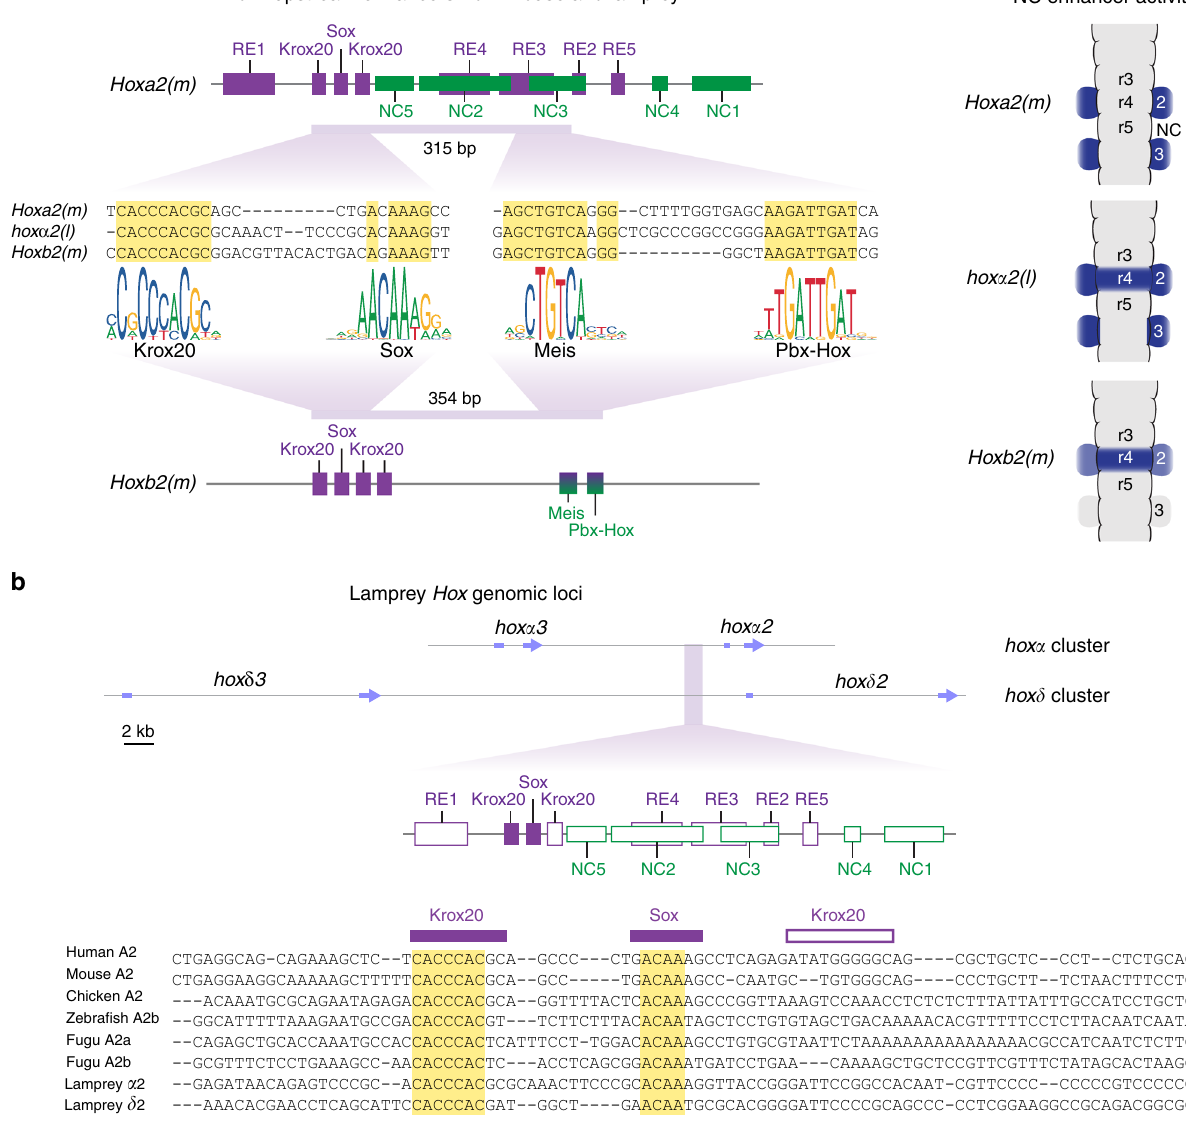
Fig. 5 Hoxa2 and Hoxb2 neural crest (NC) enhancers are ancient paralogues and the lamprey hox α 2 enhancer appears to re fl ect the ancestral state. a Sequence alignment of mouse (m) Hoxa2 and Hoxb2 NC enhancers with that of lamprey (l) hox α 2 , revealing short conserved sequence blocks (yellow). Corresponding consensus binding motifs for Krox20, Sox, Meis, and Pbx-Hox factors are shown below the alignment. These conserved sequences map to characterized cis -elements required for hindbrain (purple) or NC (green) activity in the mouse Hoxa2 (above) and Hoxb2 (below) enhancers. The 315 and 354 bp refer to the precise distances between the 5 ′ end of the Krox20 site and the 3 ′ end of the Pbx-Hox site of the mouse Hoxa2 and Hoxb2 enhancers, respectively. The activity of each NC enhancer in the hindbrain and NC is shown in schematic dorsal views. This activity differs between each enhancer, with hox α 2(l) showing the combined output of Hoxa2(m) and Hoxb2(m) . b Multiple sequence alignment of gnathostome Hoxa2 NC enhancers with a homologous region upstream of lamprey hox δ 2 . The lamprey hox α 2 - hox α 3 and hox δ 2-hox δ 3 genomic loci are depicted, with hox gene exons annotated (blue arrows). The multiple sequence alignment reveals conservation of a Krox20 and a Sox site upstream of hox δ 2 (yellow shading in alignment), but other cis -elements, including NC3 , are not conserved in sequence. This is depicted in the enhancer schematic, which details the conserved (shaded boxes) and divergent (empty boxes) cis -elements upstream of hox δ